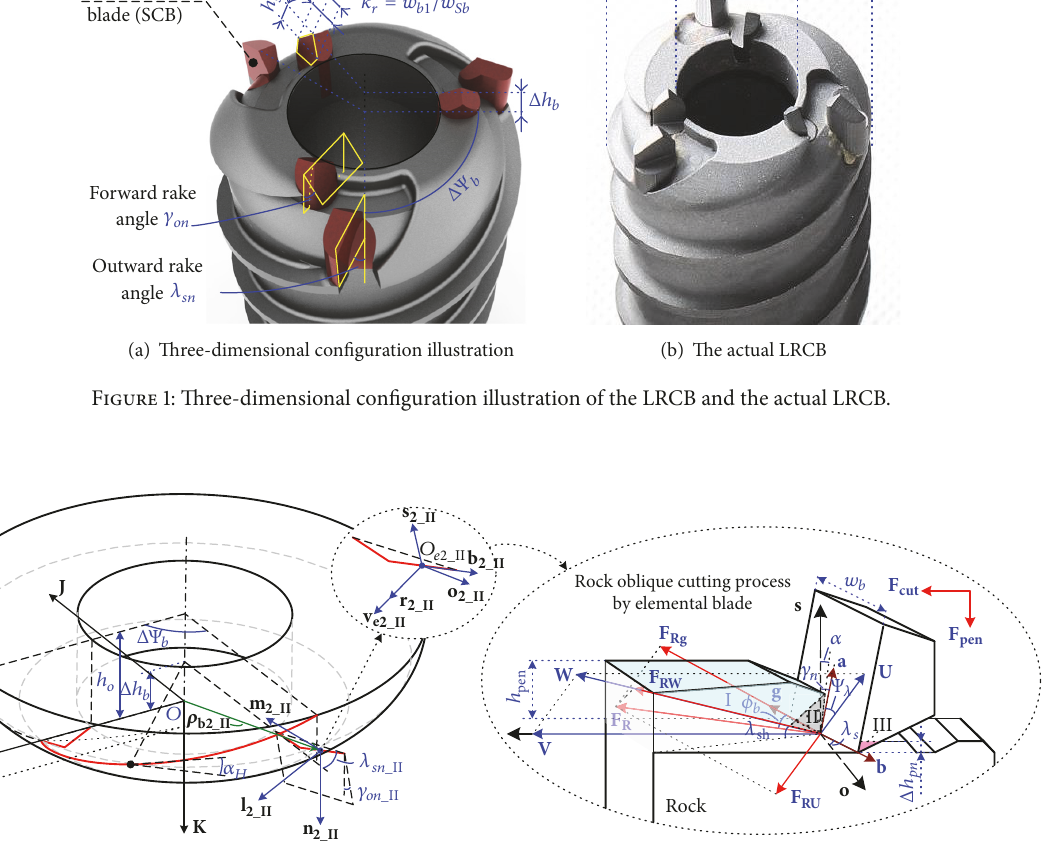
Figure 2: Curves for the LRCB’s dual-row sharp cutting blade and matrix ellipsoid spiral chip removal.